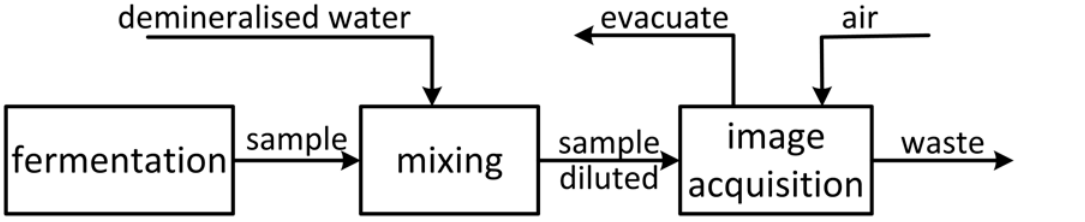
Fig 1. Simplified process flow diagram of the sample preparation and image acquisition. The sample mixed with demineralized water is pumped through the flow cell. After evacuation the image acquisition can start. Before the next sampling aeration and disposal is necessary.